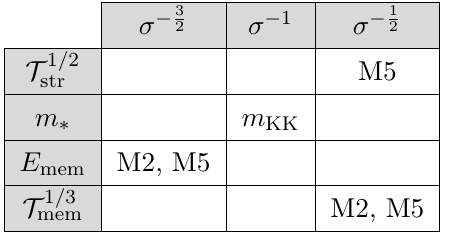
Table 14 . Mass scalings along the flows generated by the string with charges (1 , 1 , 0 , 1 , 0 , 0 , 0) .